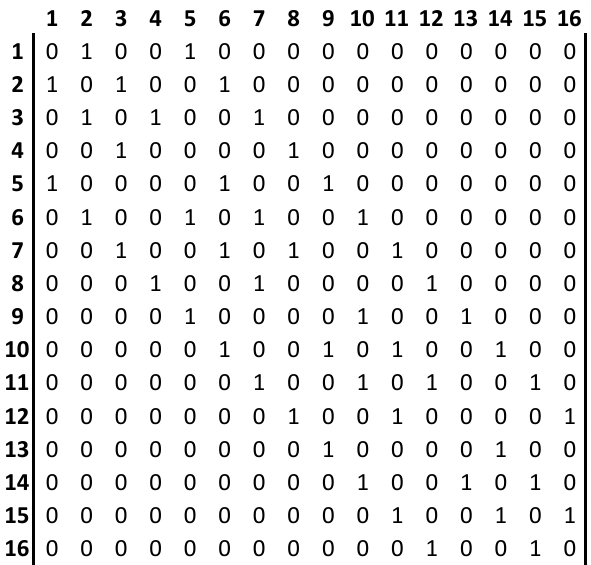
Figure 6. Spatial weights matrix.